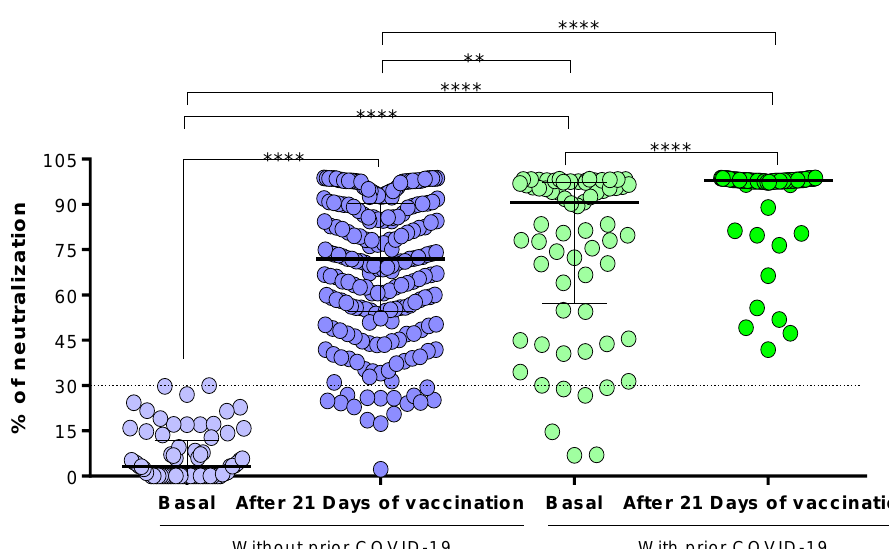
Figure 1. Percentage of neutralizing signal of antibodies generated in response to the Ad5-nCoV vaccine. ( A ) Individuals without prior COVID-19; ( B ) individuals with prior COVID-19. Differences were calculated by the Wilcoxon signed-rank test. The dotted line indicates the cut-off point for the neutralization test (>30%). The “basal” status represents the neutral- ization percentage before the effect of vaccination (3 days after vaccination).